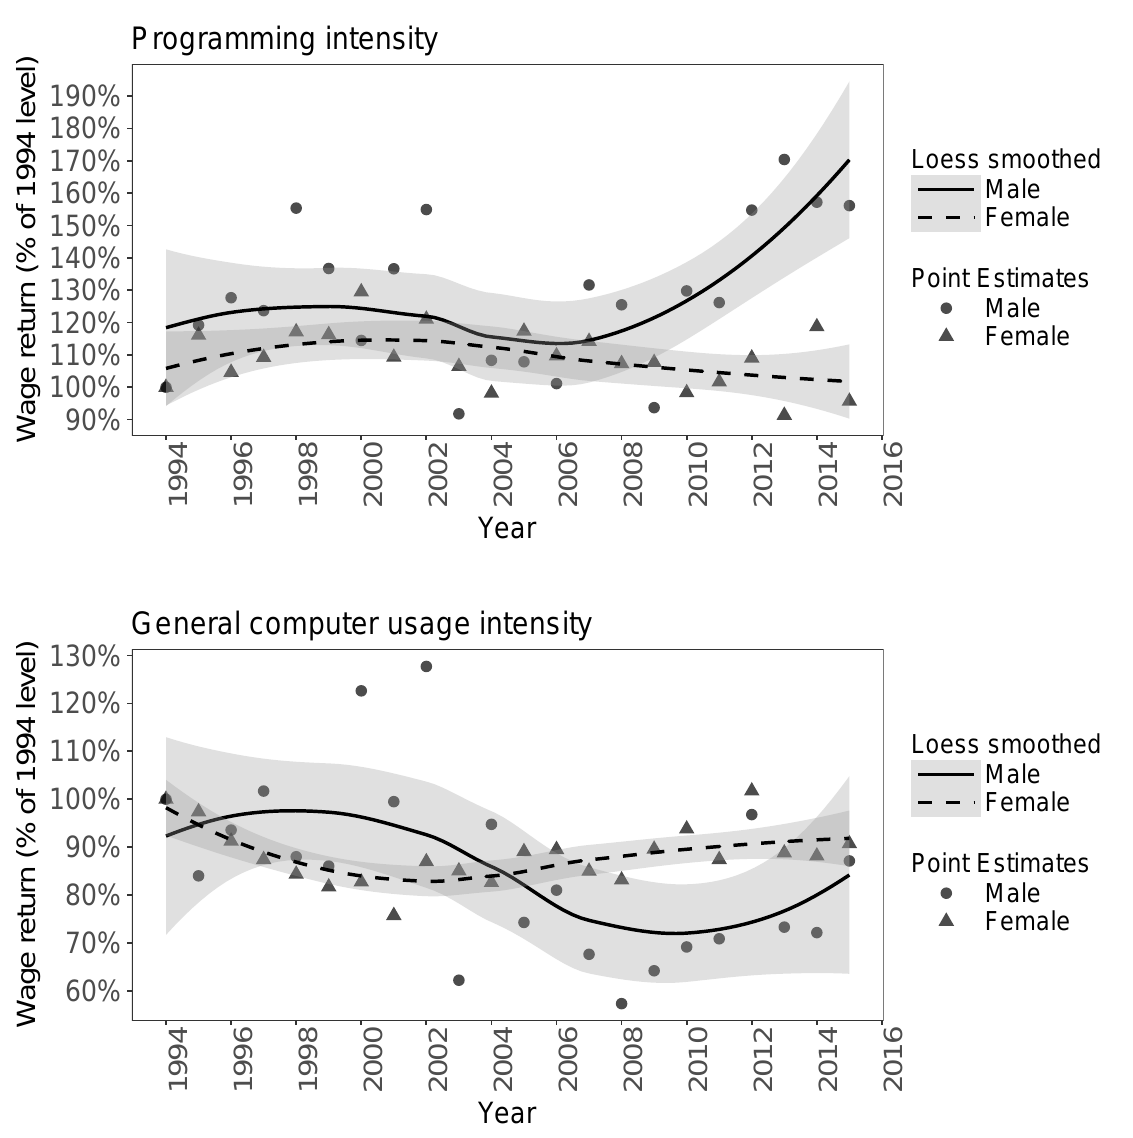
Figure 3: Gender-specific trends in wage returns (as percentage of 1994 level) to programming intensity and general computer usage intensity. See Table 2 for the data source. Solid and dashed lines represent the Loess-smoothed curve with a span of 0.5, and shaded areas represent 95 percent confidence intervals. Alternative span widths yield similar